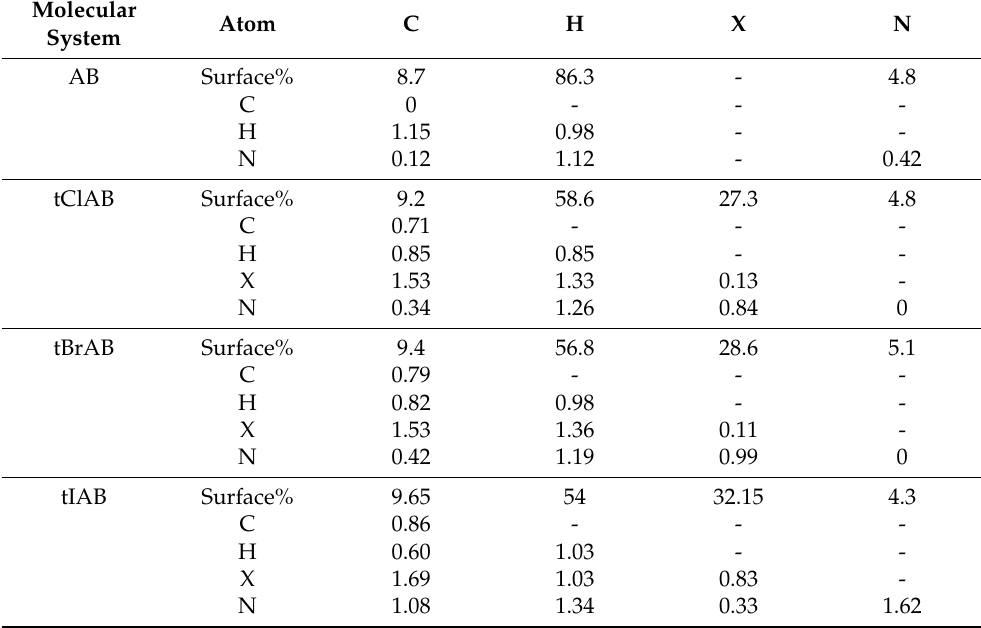
Table 6. Enrichment ratios E XY characterizing the various contacts in the set of compounds studied.